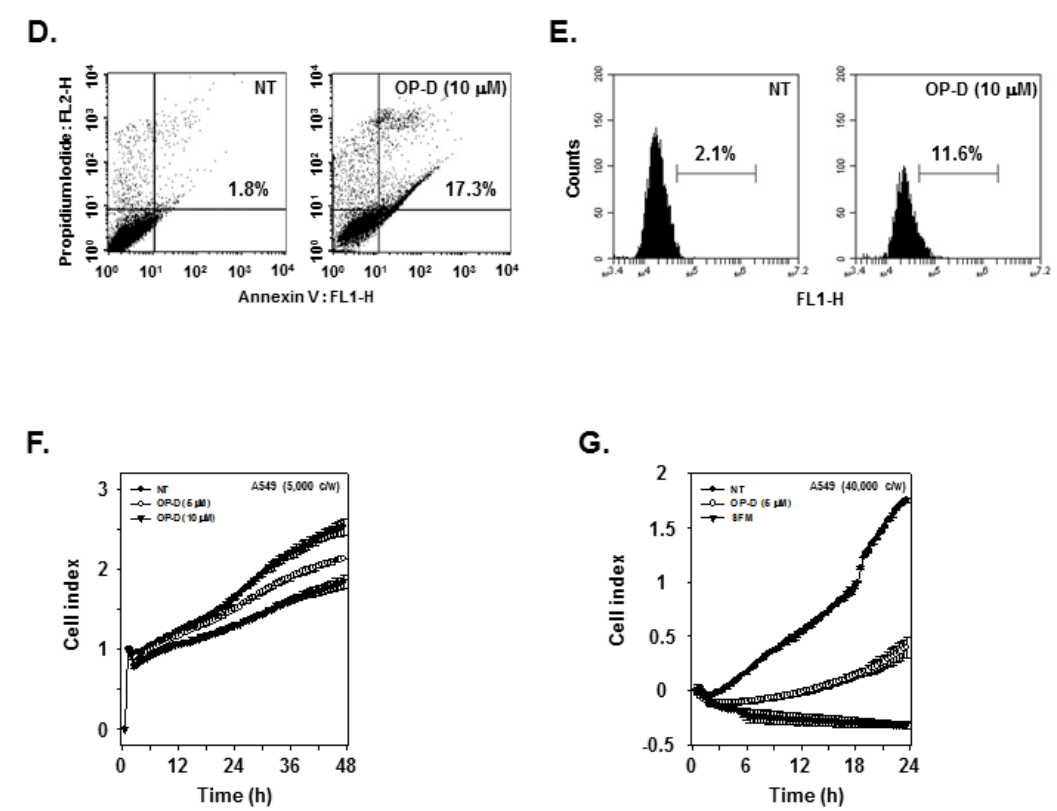
Figure 3. OP-D induces apoptosis, inhibits cell proliferation and invasion. ( A ) A549 cells were treated with the indicated concentrations of OP-D for 24 h and Western blotting was done. ( B ) A549 cells were treated with the indicated concentrations of OP-D for 6 h and reverse transcription-polymerase chain reaction (RT-PCR) was carried out. ( C ) A549 cells were treated as described in panel A and Western blotting was done. ( D ) A549 cells were treated with 10 µM of OP-D for 24 h, stained with FITC (Fluorescein-5-isothiocyanate)-conjugated anti-Annexin V, and flow cytometer was used for analysis. ( E ) A549 cells were treated as described in panel D, fixed, incubated with a TUNEL (terminal deoxynucleotidyl transferase dUTP nick end labeling) reaction solution and analyzed using flow cytometer. ( F ) A549 cells were treated with 5, 10 µM of OP-D and then cell proliferation assay was performed using the Roche xCELLigence Real-Time Cell Analysis (RTCA). ( G ) A549 cells were plated onto a matrigel-coated 16-well CIM-plates, treated with 5 µM of OP-D and then invasion assay was performed using RTCA.